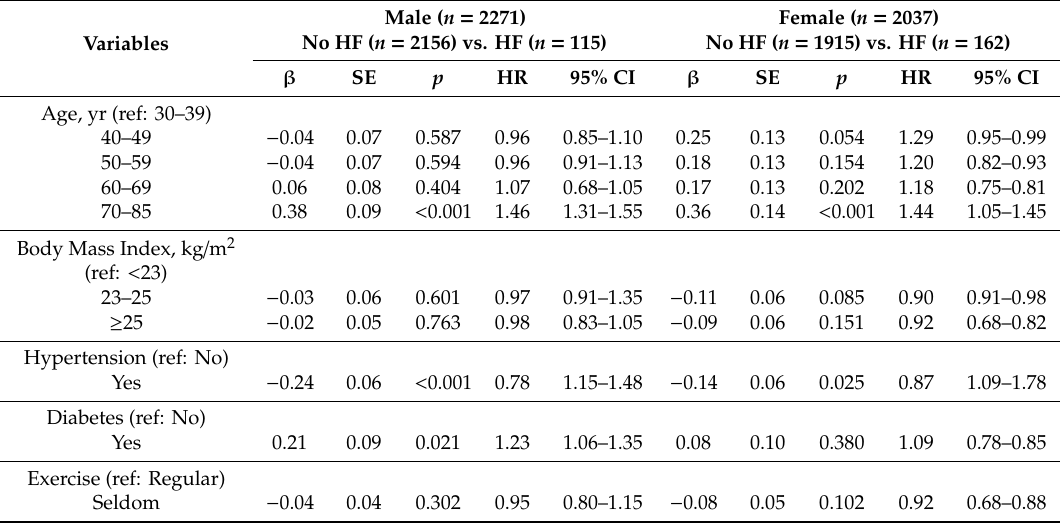
Table 2. Cox-Hazard regression analysis for predicting factors on incidence of heart failure by